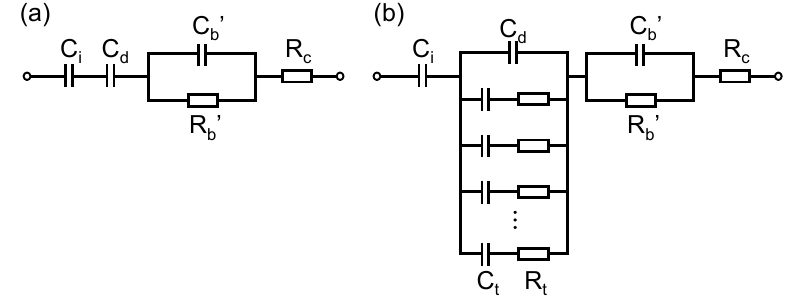
Figure 3. Frequency dependences of the conductance loss ( G / ω ) of the ITO/PI/P3HT/Au MIS capacitors with ( a ) patterned and ( b ) unpatterned P3HT films measured at various gate voltages.